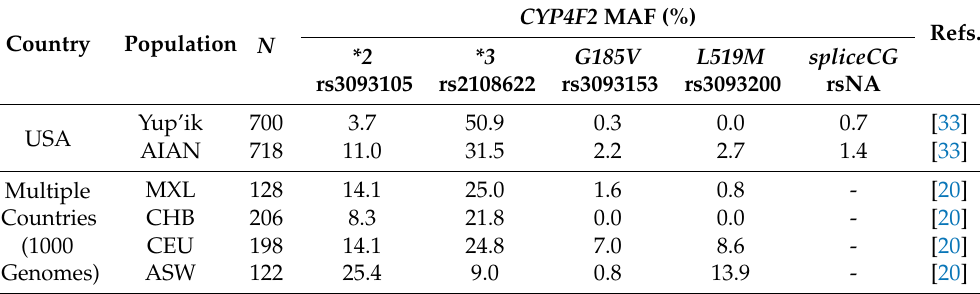
Figure 13. The human CYP4F2 gene and SNVs detected in the Yup’ik and SCF populations. Not shown is CYP4F2 spliceCG , a novel splice variant that changed the splice site of exon 1. Exon 1 is untranslated in CYP4F2. Open boxes represent exons, lines represent introns and shaded boxes represent UTR. Table 13. Comparison of CYP4F2 allele frequencies Indigenous North American populations to global populations from the 1000 Genomes Project [20]. N represents the number of alleles. Global populations are abbreviated as follows: African Ancestry in Southwest US (ASW); Utah residents with Northern and Western European ancestry (CEU); Han Chinese in Beijing, China (CHB); Mexican Ancestry in Los Angeles, California (MXL).